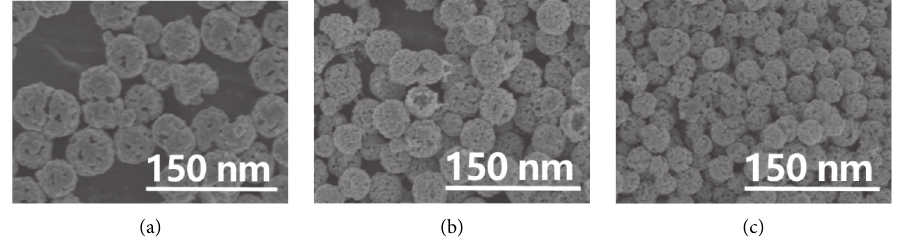
Figure 5: Porous nanostructures obtained by Au I etching: (a) Ag